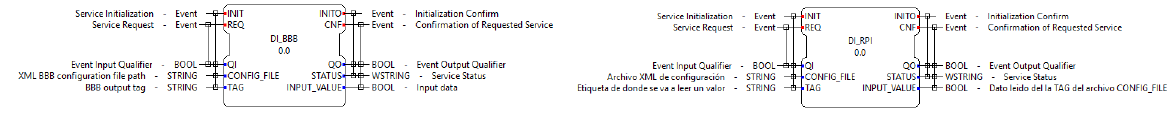
Figure 8. SIFBs for digital input in BBB and RPI.